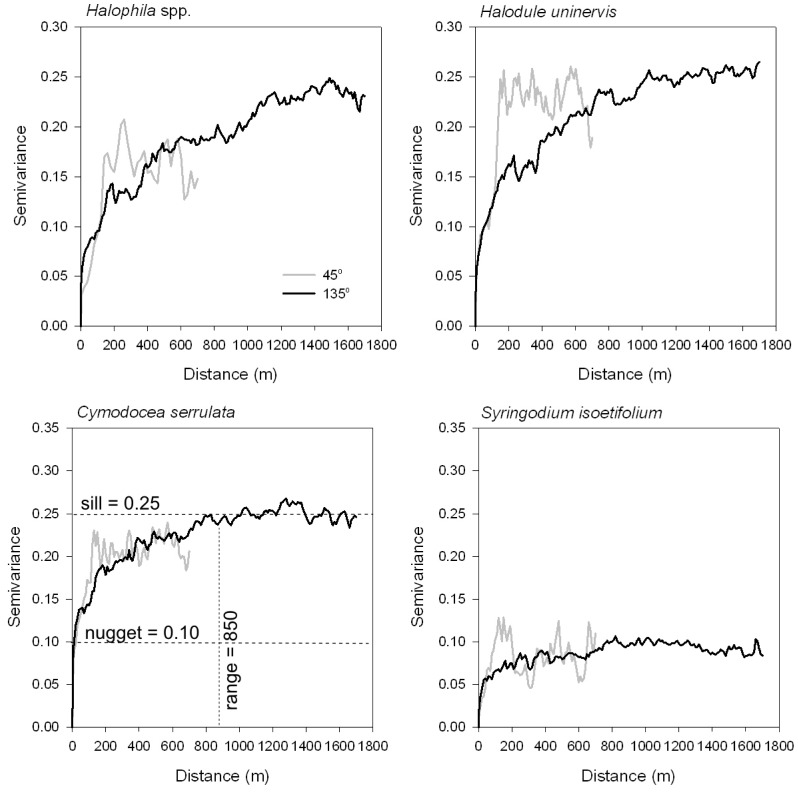
Directional variograms for presence/absence of four seagrass species in the along-shore (135°) and across-shore (45°) of Pulau Tinggi, Peninsular Malaysia.Other directions (0° = north-south and 90° = east-west) were modeled but are not shown. Variograms were plotted for half the maximum distance between points in each direction, lag 10 m, tolerance 5 m. The theoretical variogram structures (nugget, range and sill) are shown for Cymodocea serrulata.